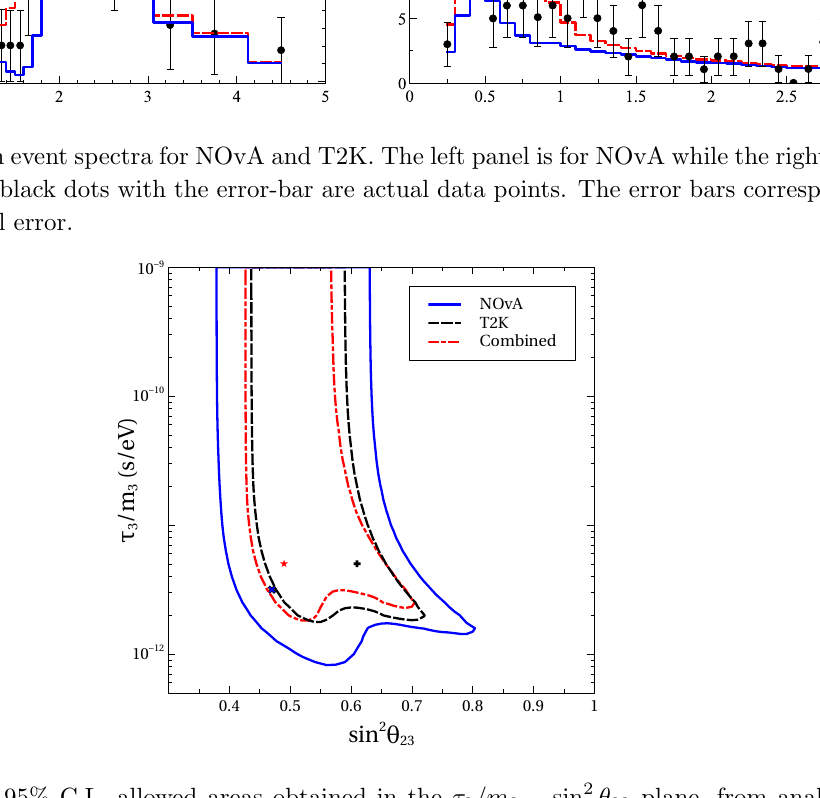
Figure 5 . The 95% C.L. allowed areas obtained in the (cid:28) 3 =m 3 (cid:0) sin 2 (cid:18) 23 plane, from analysis of T2K data (black dashed line), NOvA data (blue solid line) and T2K+NOvA data (red dashed- dotted